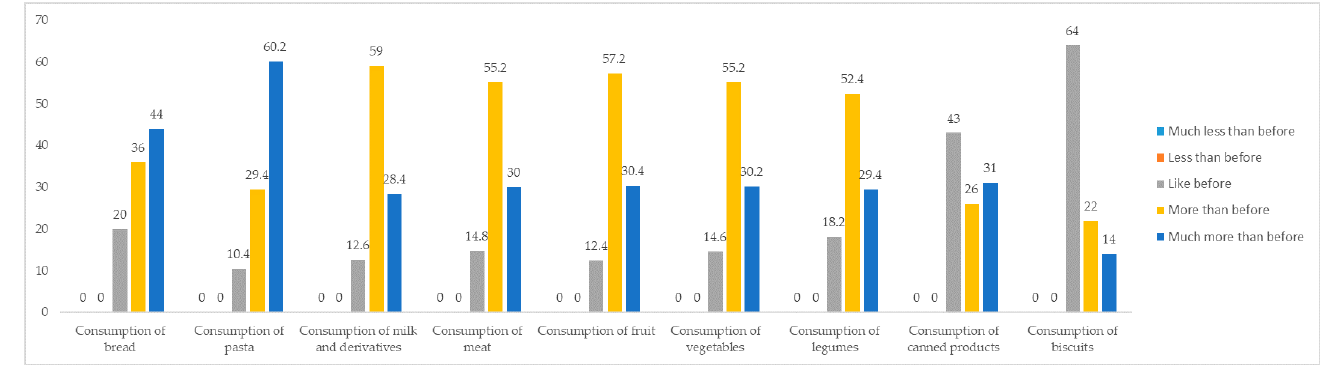
Figure 4. Changes in food consumption. Source: own processing of pilot survey.